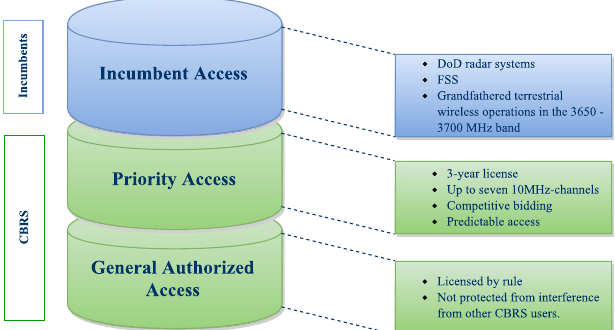
Figure 2. Three-tier sharing